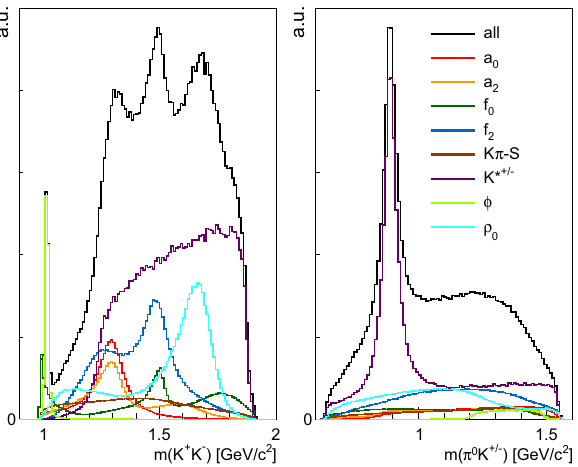
Fig. 16 Efficiency corrected invariant K + K − -(left) and K ± π 0 -mass (right) for the reaction ¯ pp → K + K − π 0 . The overall result is marked in black, while the individual contributions are visualized by different colors ¯ pp → K + K − π 0 and for the spin-exotic wave π reaction ¯ pp → π 0 π 0 η derived from the final fit result are discussed in the following. Due to the fact that the infor- mation on the beam luminosity is not accessible anymore, only the relative cross sections could be extracted.